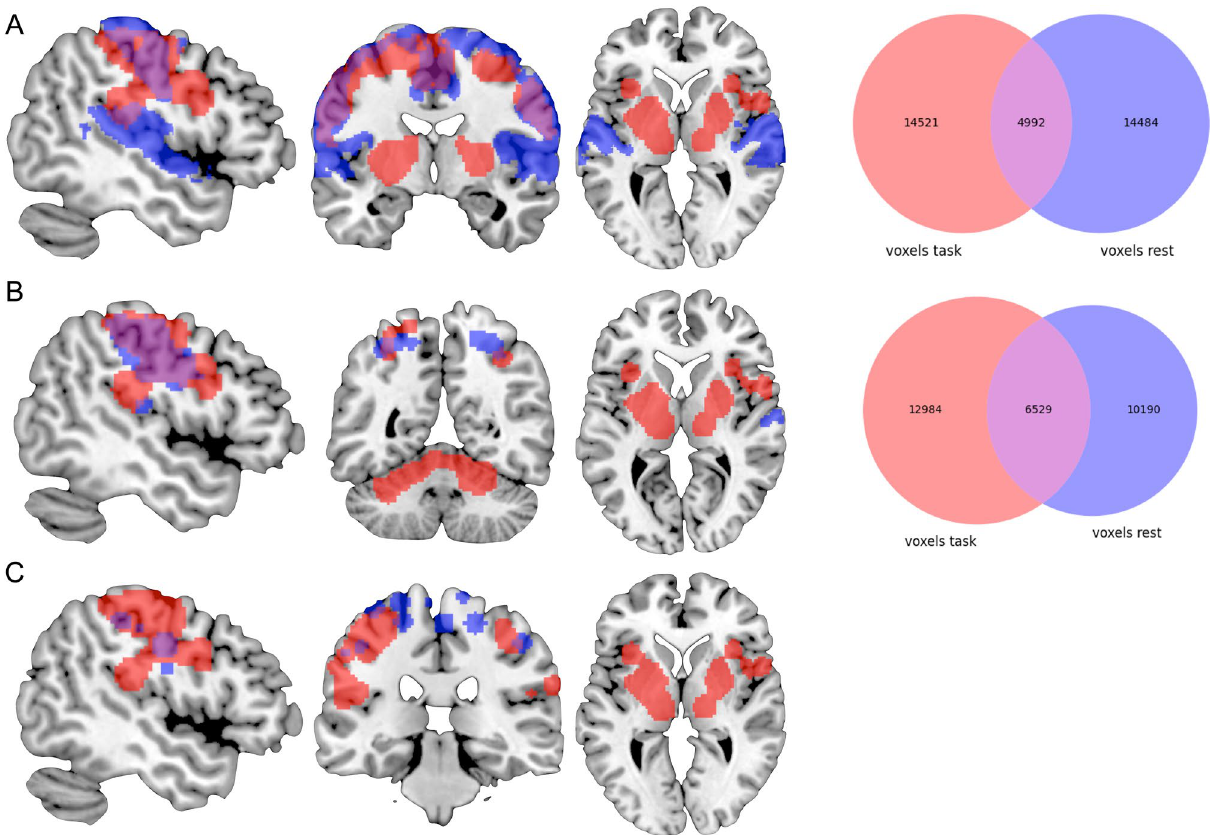
Figure 8. Overlap between the task-based (red) and resting-state-derived (blue) motor-related networks by ( A ) Yeo et al. 28 , ( B ) Smith et al. 17 , and ( C ) Power et al. 29 . For Power et al.’s graph nodes spheres of 6 mm were added for illustrative purposes. The Venn diagrams on the right illustrate the number of voxels either network as well as the overlap in between these networks comprises. Brain networks were rendered on the individual anatomical template (“ch2better”) provided with MRIcron 25 . Venn diagrams were created using the Python package